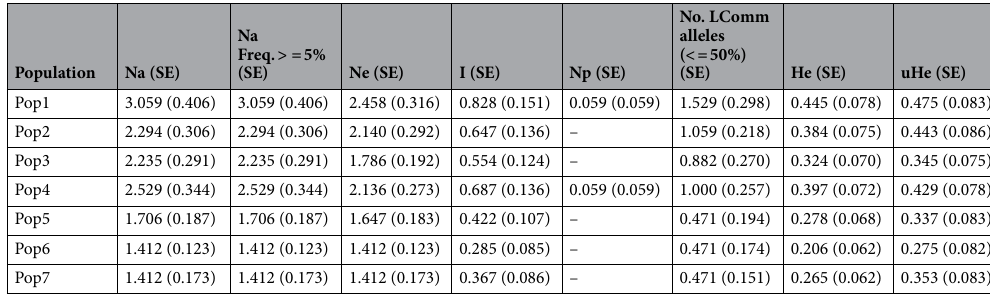
Table 2. Mean allelic patterns across populations of Sambucus wightiana . Na = No. of Different Alleles. Na (Freq > = 5%) = No. of Different Alleles with a Frequency > = 5% Ne = No. of Effective Alleles = 1/(Sum pi^2). I = Shannon’s Information Index = − 1* Sum (pi * Ln (pi)). No. Private Alleles = No. of Alleles Unique to a Single Population. No. LComm Alleles (< = 25%) = No. of Locally Common Alleles (Freq. > = 5%) Found in 25% or Fewer Populations. No. LComm Alleles (< = 50%) = No. of Locally Common Alleles (Freq. > = 5%) Found in 50% or Fewer Populations. He = Expected Heterozygosity = 1 − Sum pi^2. uHe = Unbiased Expected Heterozygosity = (2 N/(2 N − 1)) *